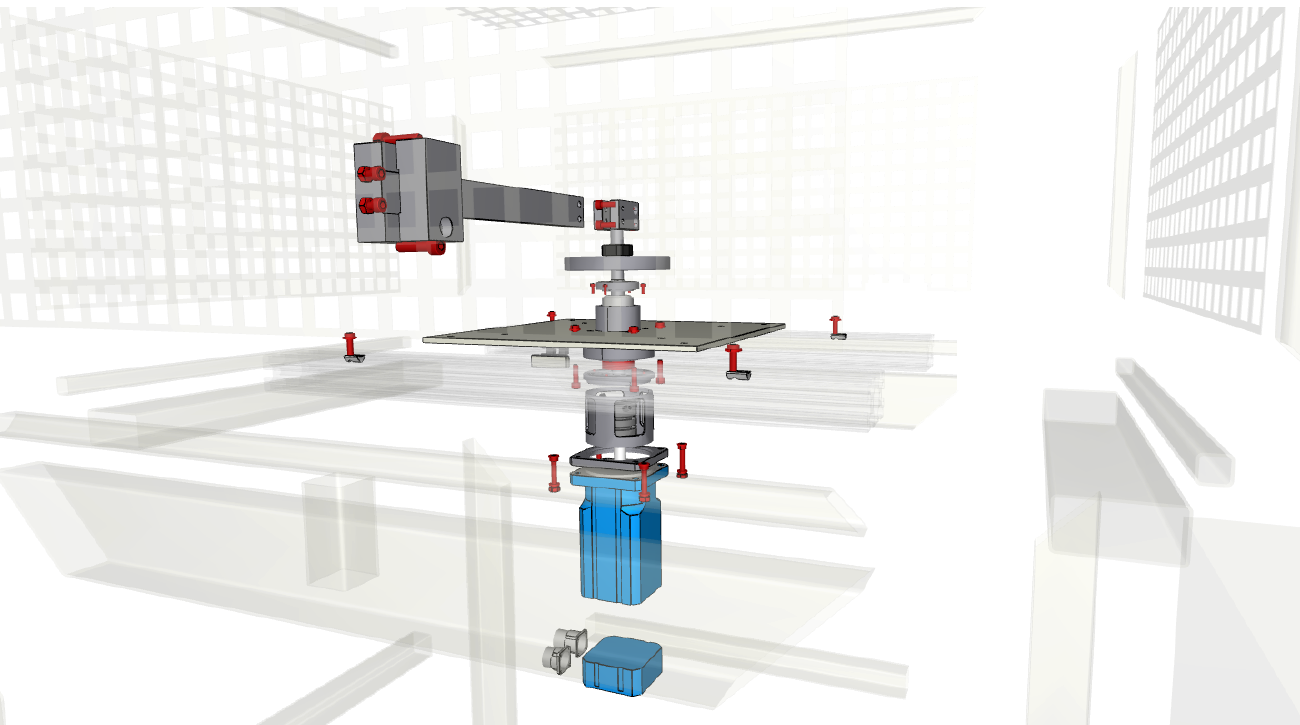
Figure 2. Flexible arm motion stage details: drive to arm transmission assembly consisting of electrical drive, flexible coupling, bearing housing, inertial load, and adjustable compliant